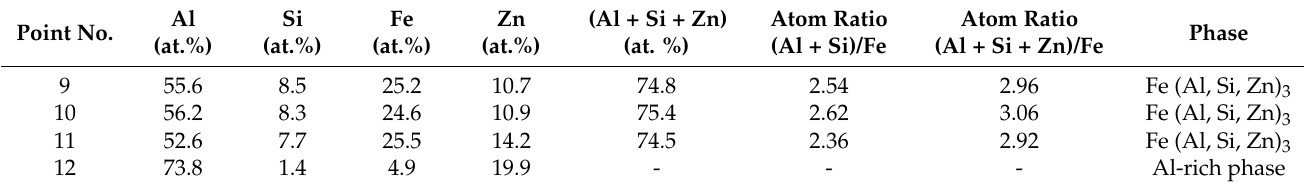
Table 5. Results of the EDS analysis of the outer layer of coatings and the corresponding phase (analysis points as shown in Figure